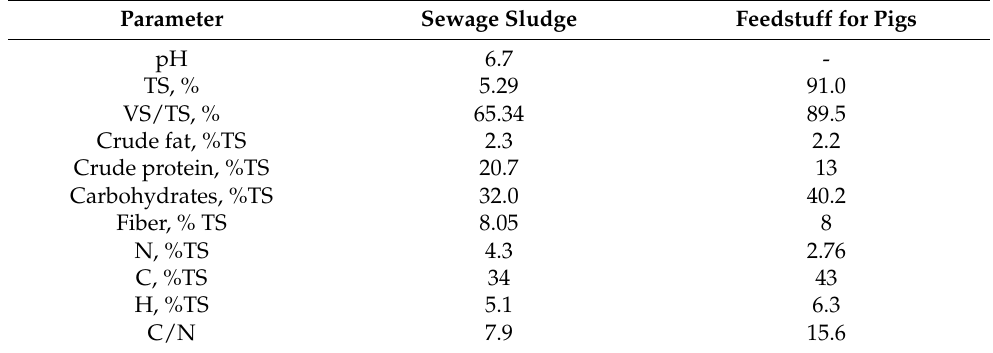
Table 1. Characteristics of cosubstrates.